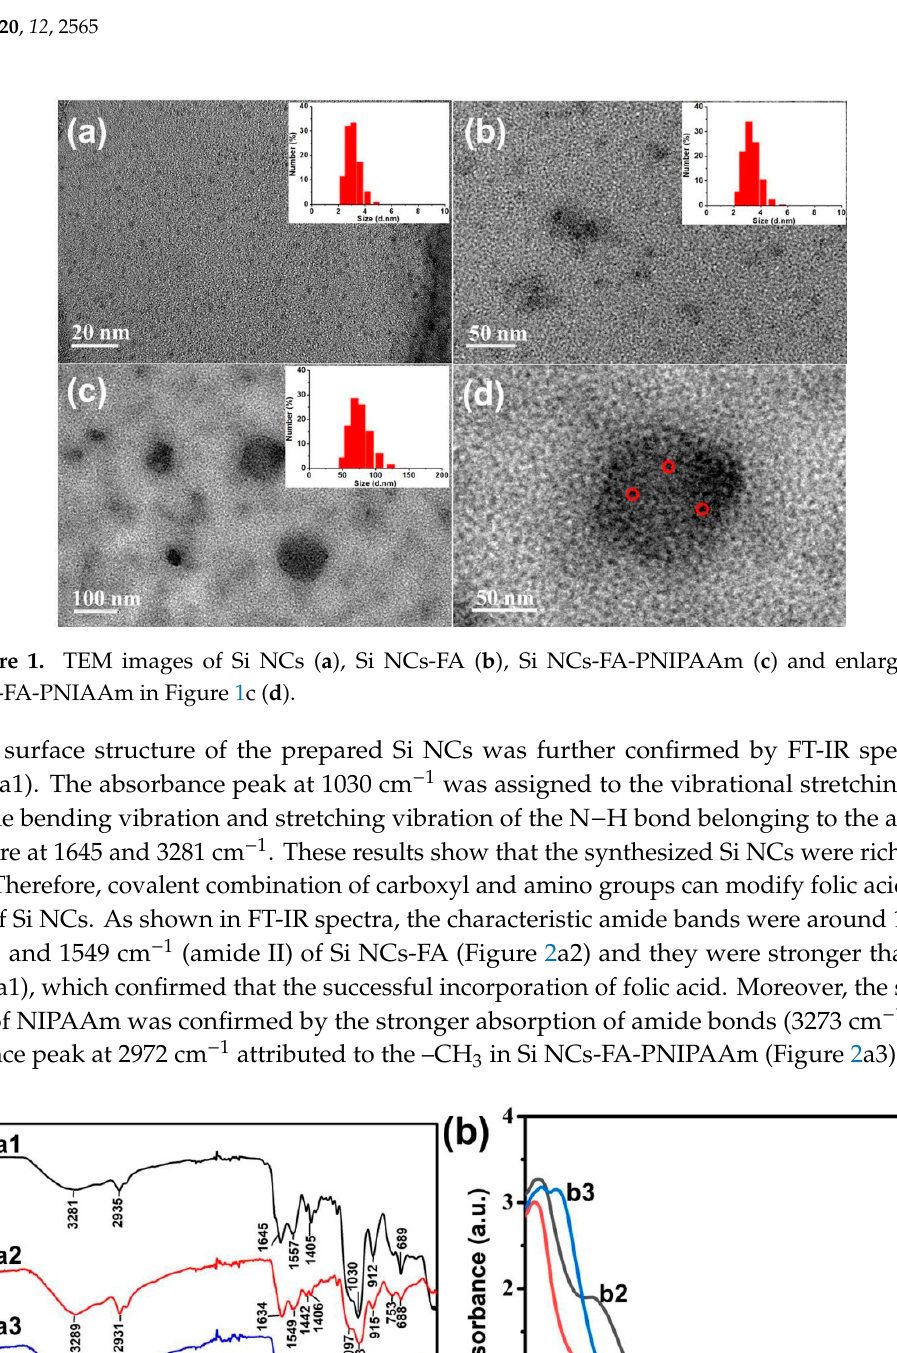
Figure 2. ( a ) FT-IR spectroscopy of Si NCs (a1), Si NCs-FA (a2), Si NCs-FA-PNIPAAm (a3); ( b ) UV-vis spectra of Si NCs (b1), Si NCs-FA (b2), Si NCs-FA--PNIPAAm (b3), the concentration of them was 5 μ g/mL.